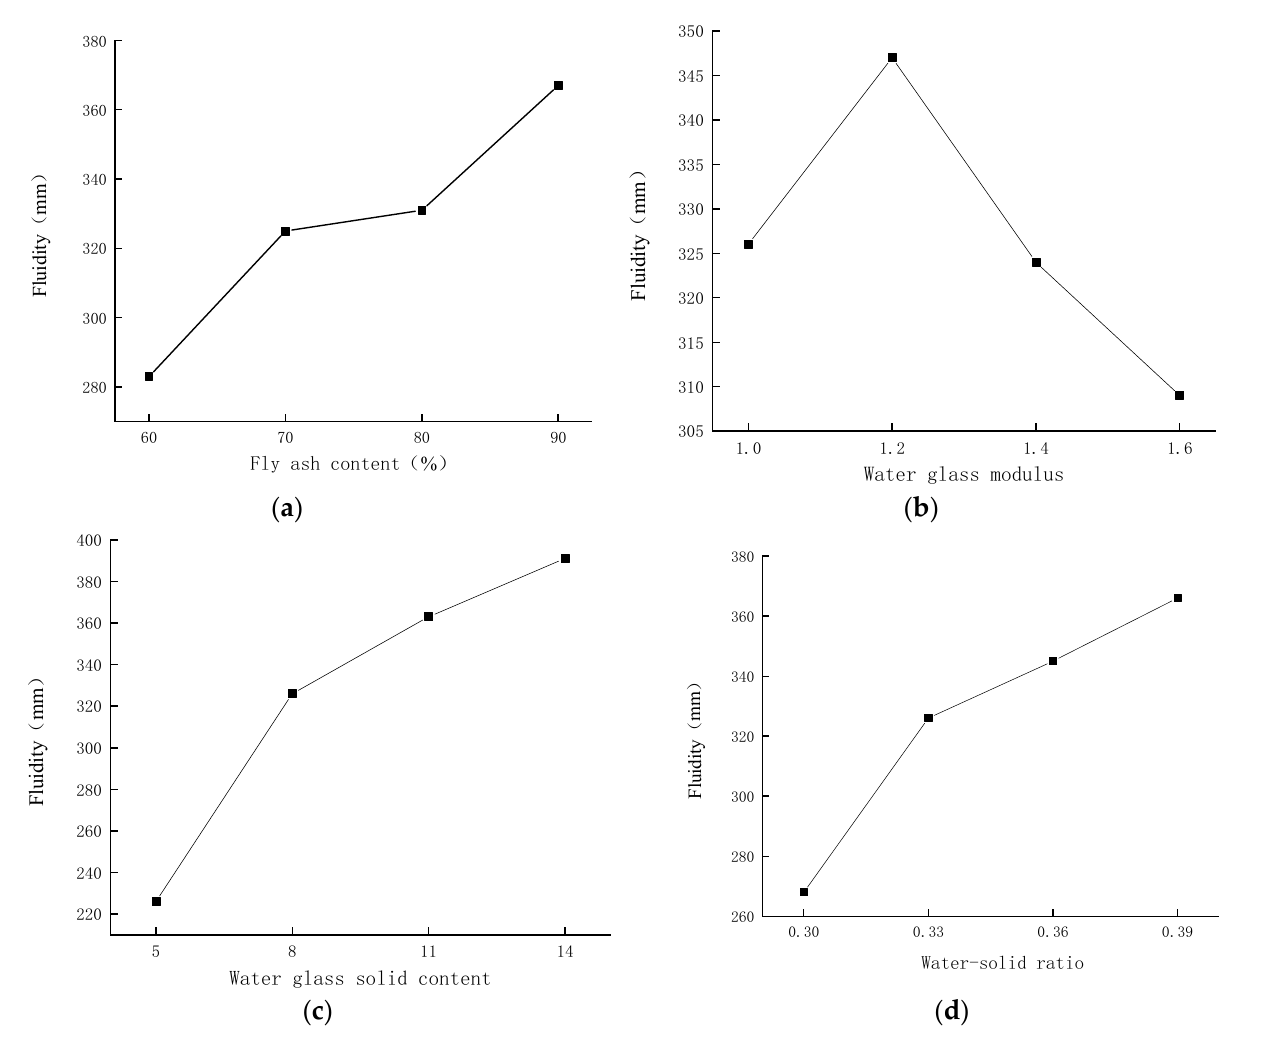
Figure 2. Influence of parameters on fluidity of composite gelling system. ( a ) Influence of fly ash content on fluidity. ( b ) Influence of water glass modulus on fluidity. ( c ) Influence of water glass solid content on fluidity. ( d ) Influence of water–solid ratio on fluidity.